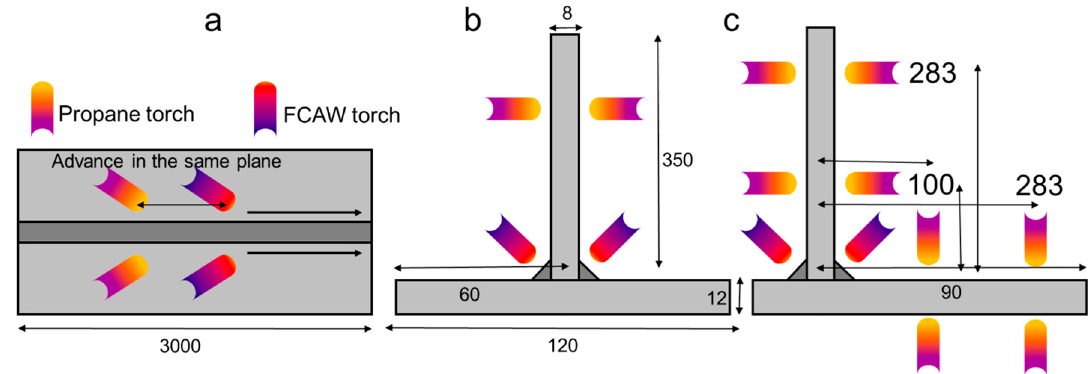
Figure 1. Schematic of the manufacturing process with the size of the T-joint. (dimensions in mm). ( a ) Distance between process torches; ( b ) P1 geometry; ( c ) P2 geometry.